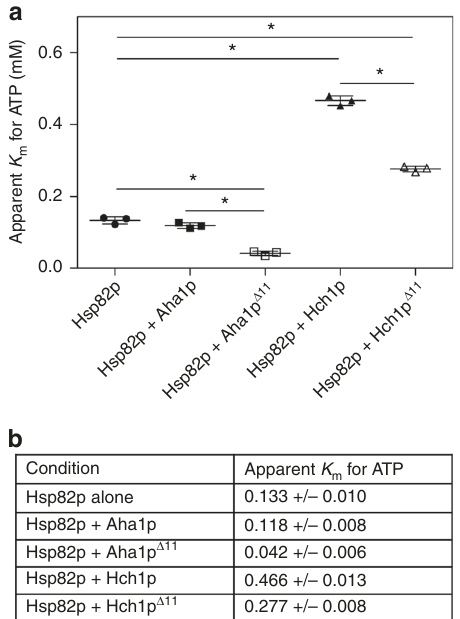
Fig. 7 The NxNNWHW motif modulates the apparent K M for ATP of Hsp90. a Kinetic analysis was carried out for Hsp82p alone or in the presence of Aha1p, Aha1p Δ 11 , Hch1p, or Hch1p Δ 11 . ATPase reactions were carried out with increasing concentrations of ATP (12.5, 25, 50, 100, 200, 400, 800, 1600 μ M) and ATPase rates were analyzed with the Michaelis – Menten non-linear regression function in GraphPad Prism. The curve fi ts all had R 2 values >0.9. The apparent K M values for three experiments are shown in the scatter plots. Statistical signi fi cance (*) was calculated pair-wise with a t -test ( n = 3; n = 4 for Hsp82p alone). Error bars show standard deviation. b Table showing K M values plotted in